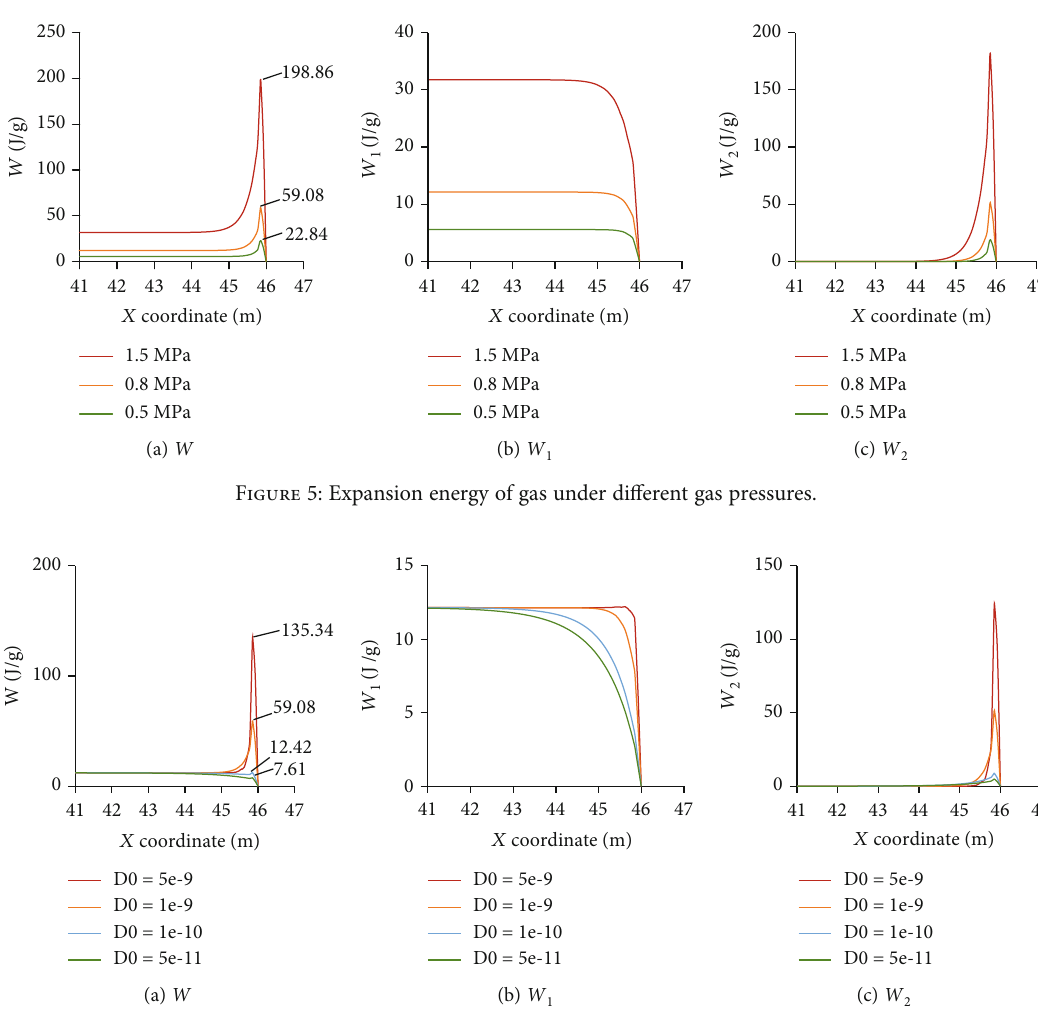
Figure 6: Expansion energy of gas under di ff erent di ff usion coe ffi